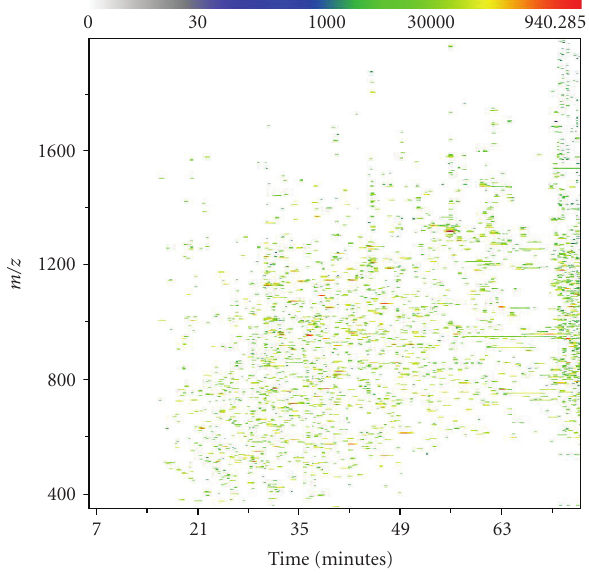
Figure 7: A representation of aligned data features generated by Rosetta Elucidator from the control-pre mass spectrum. The m/z measurement from the mass spectrometer is plotted against the liquid chromatography elution time, with a scale of color depicting the intensity (total ion current or TIC) measured at each point. The Elucidator system defines features by mathematically identifying local intensity peak regions against background